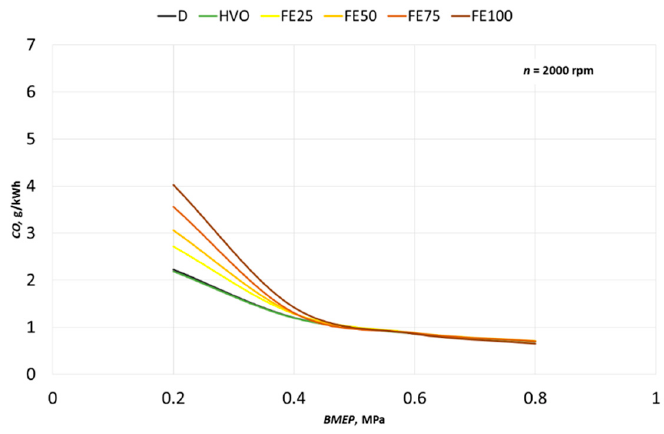
Figure 10. Dependence of carbon monoxide emissions on the load. For blends with ester, this tendency was also higher compared to fossil fuel. For FE25, FE50 and FE75, carbon monoxide emissions were ~6%, 7%,